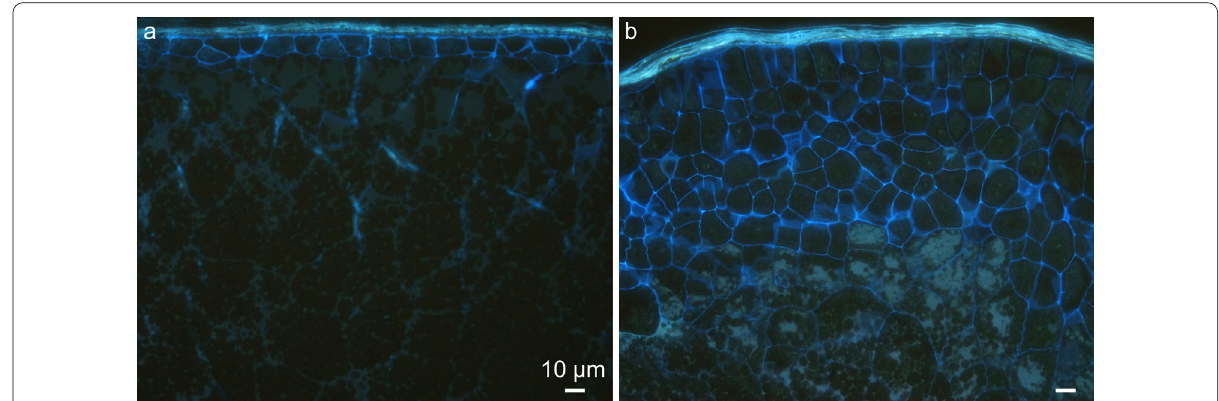
Fig. 3 Calcofluor White staining with epifluorescence showing the cell wall structure and organization of the transverse section of the rice caryopsis. a the wild type; b ta2-1 . Scale bar 10 µm =